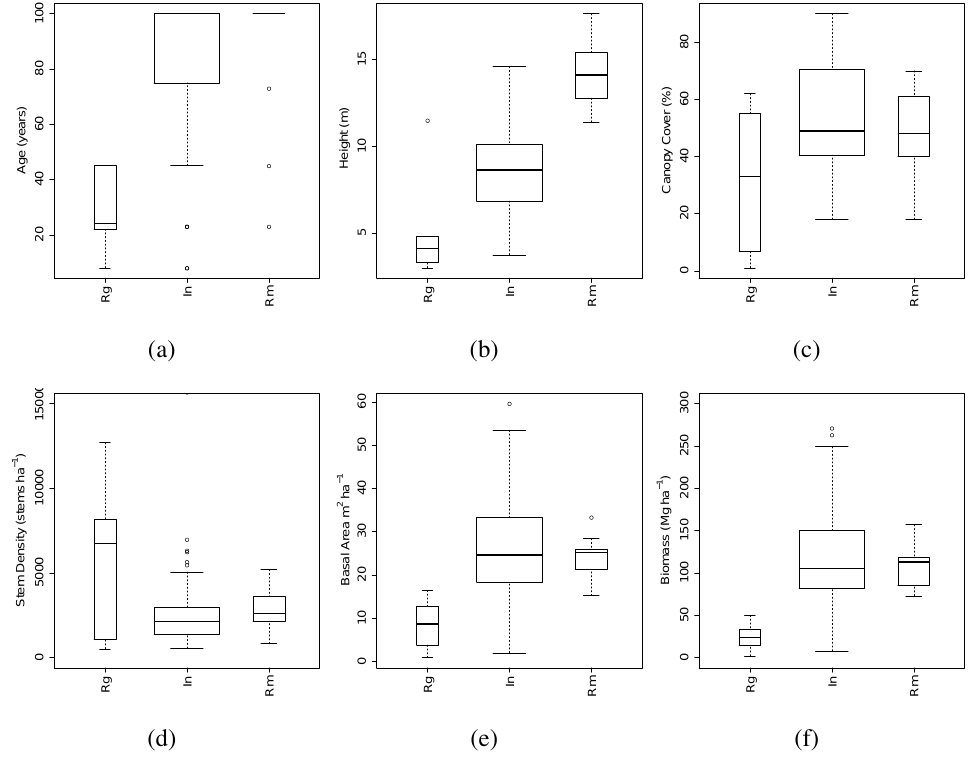
Figure 2. The distribution of ( a ) age, ( b ) median canopy height, ( c ) canopy cover and ( d ) stem density, ( e ) basal area and ( f ) biomass for field plots classified into three stages of regrowth (early-stage (Rg), intermediate (In) and remnant (Rm)) based on height and canopy cover relative to those of undisturbed